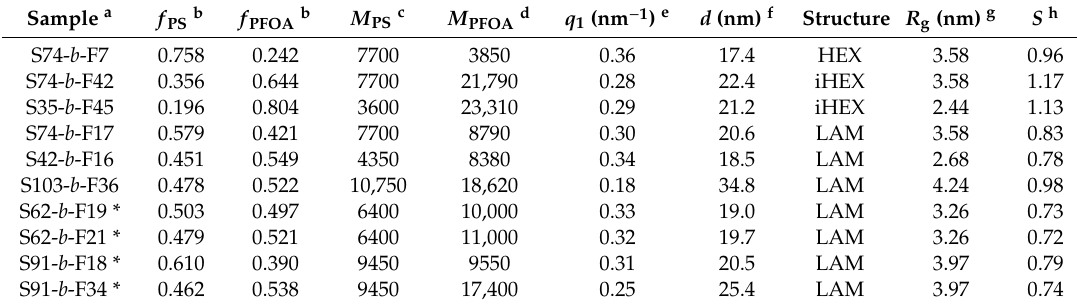
Table 1. Molecular characterization of S- b -F block copolymers.